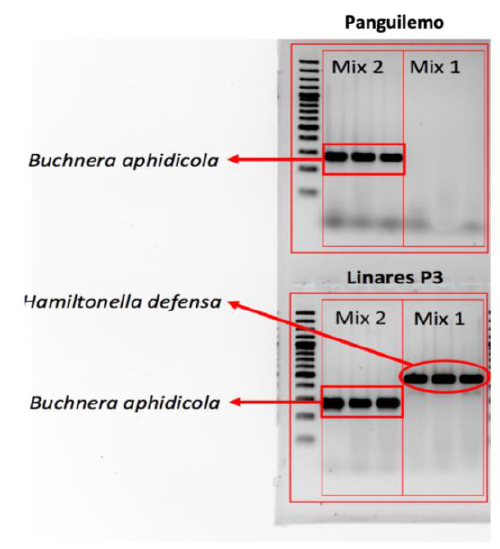
Figure A1. The PCR screening of endosymbionts in A. pisum clones − E (above) and +E (below) .